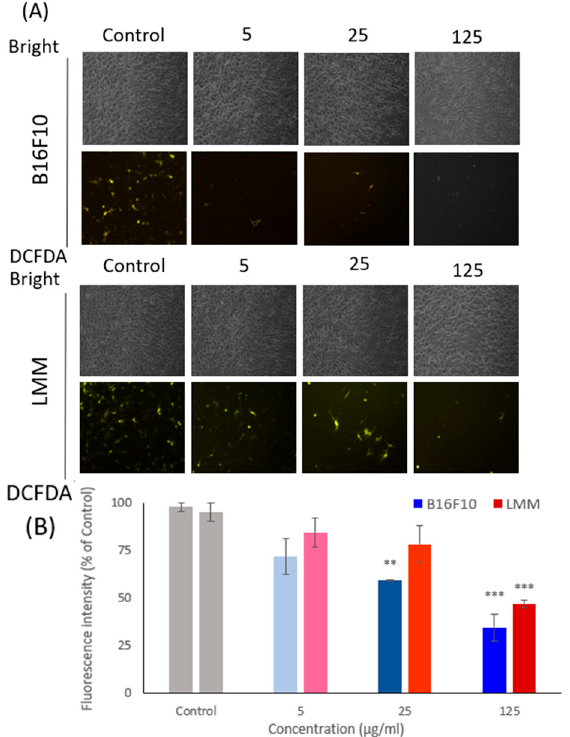
Figure 3. ( A ) The oxidative pressure inner B16F10 and LMM were tested by DCFDA fluorescent staining under a fluorescent microscope after conducted 5, 25, and 125 μ g/mL CM. ( B ) The fluores- cence intensity was analyzed in B16F10 and LMM after adopted 5, 25, and 125 μ g/mL CM. ** p < 0.01, *** p < 0.005.